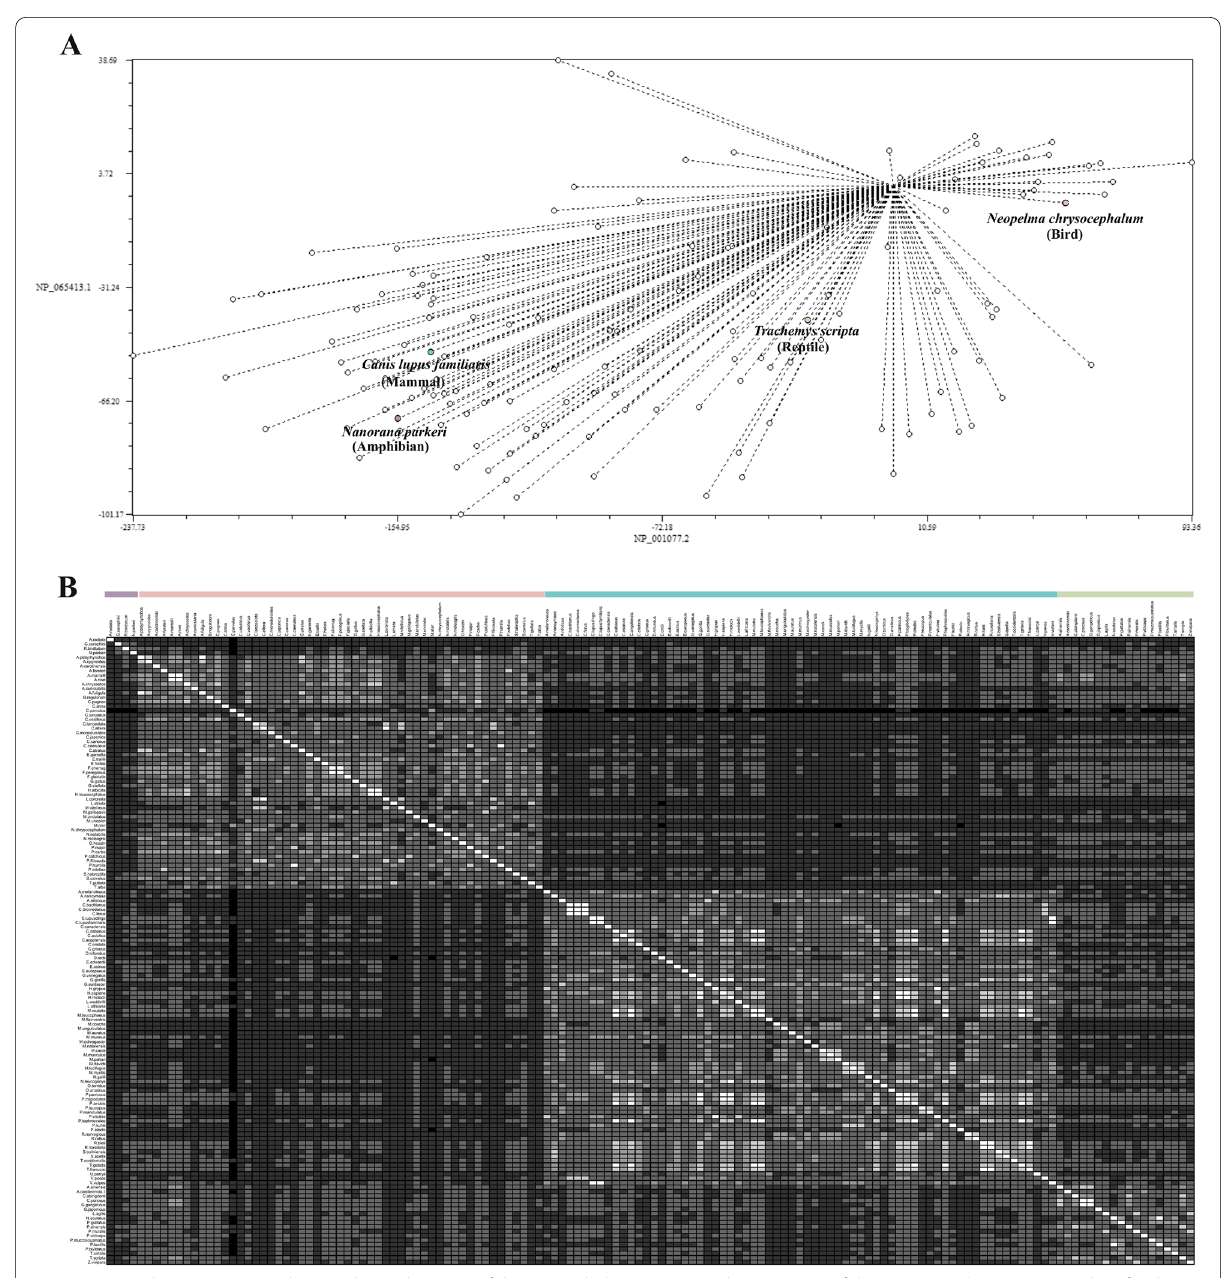
Fig. 2 Principal component analysis. A The Fitch matrix of the 142 orthologues. B Correlation matrix of the amino acid sequences coding for the AADAC genes, the Dis/similarity matrix was created in NTSYSpc; amphibian organisms are represented in purple, avian organisms are represented in pink, mammalian organisms are represented in blue, and reptiles in